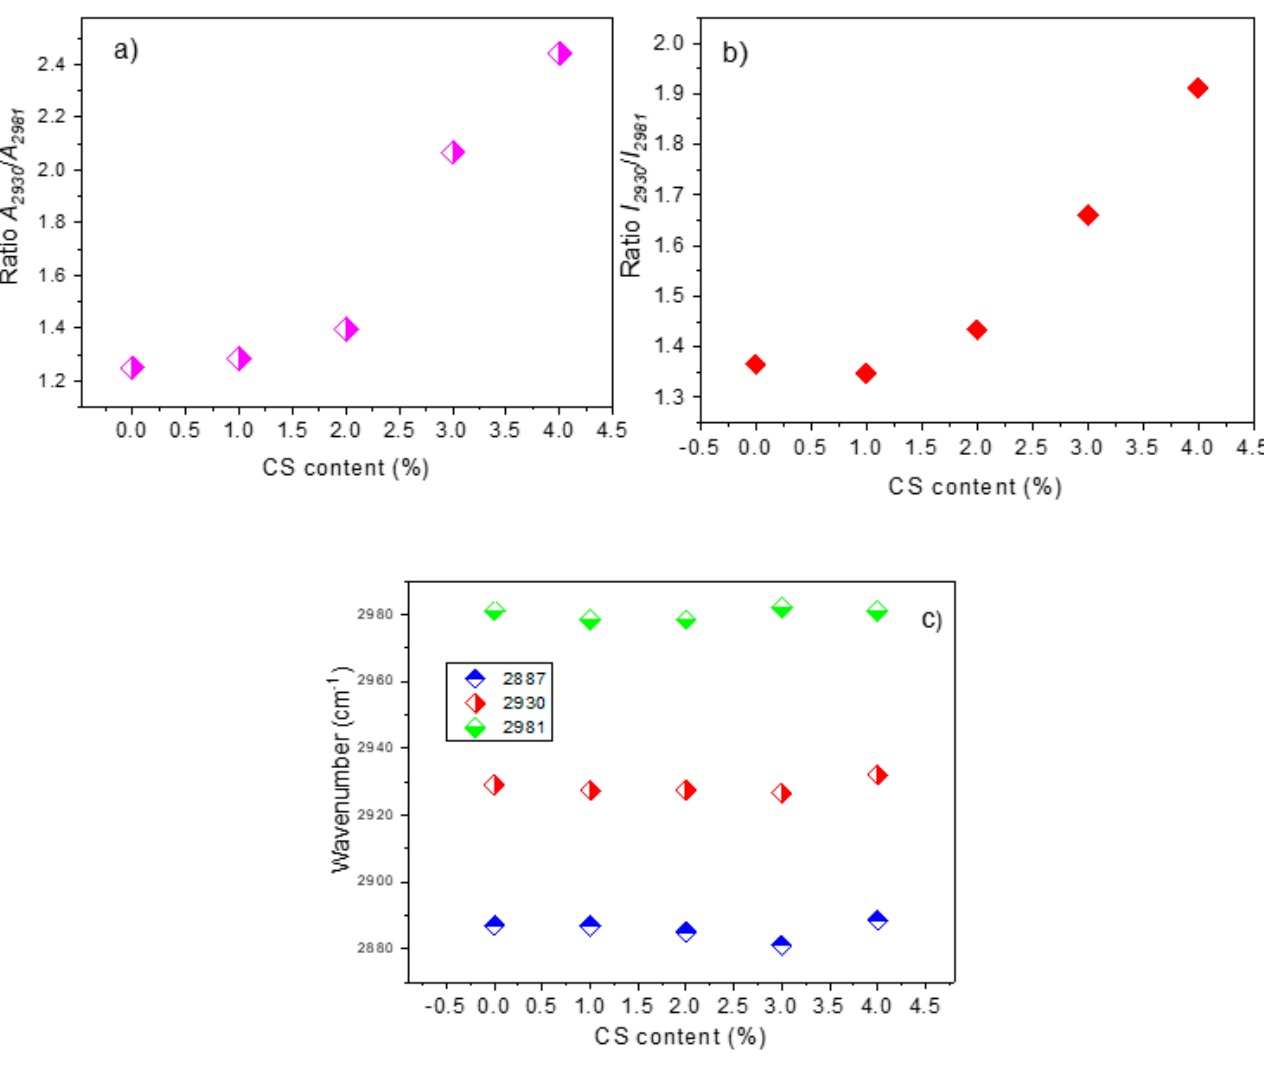
Figure 5. The dependence of ratios of ( a ) integrated intensities A 2930 /A 2981 and ( b ) peak intensities I 2930 /I 2981 of bands at 2930 cm − 1 and 2981 cm − 1 , obtained after fitting the high-frequency band in the range 2720–3130 cm − 1 shown in Figure 4. ( c ) The dependence of peak positions of three bands at 2887, 2930 and 2981 cm − 1 obtained during fitting. No significant changes in these peak positions are seen for all three bands at different CS content.